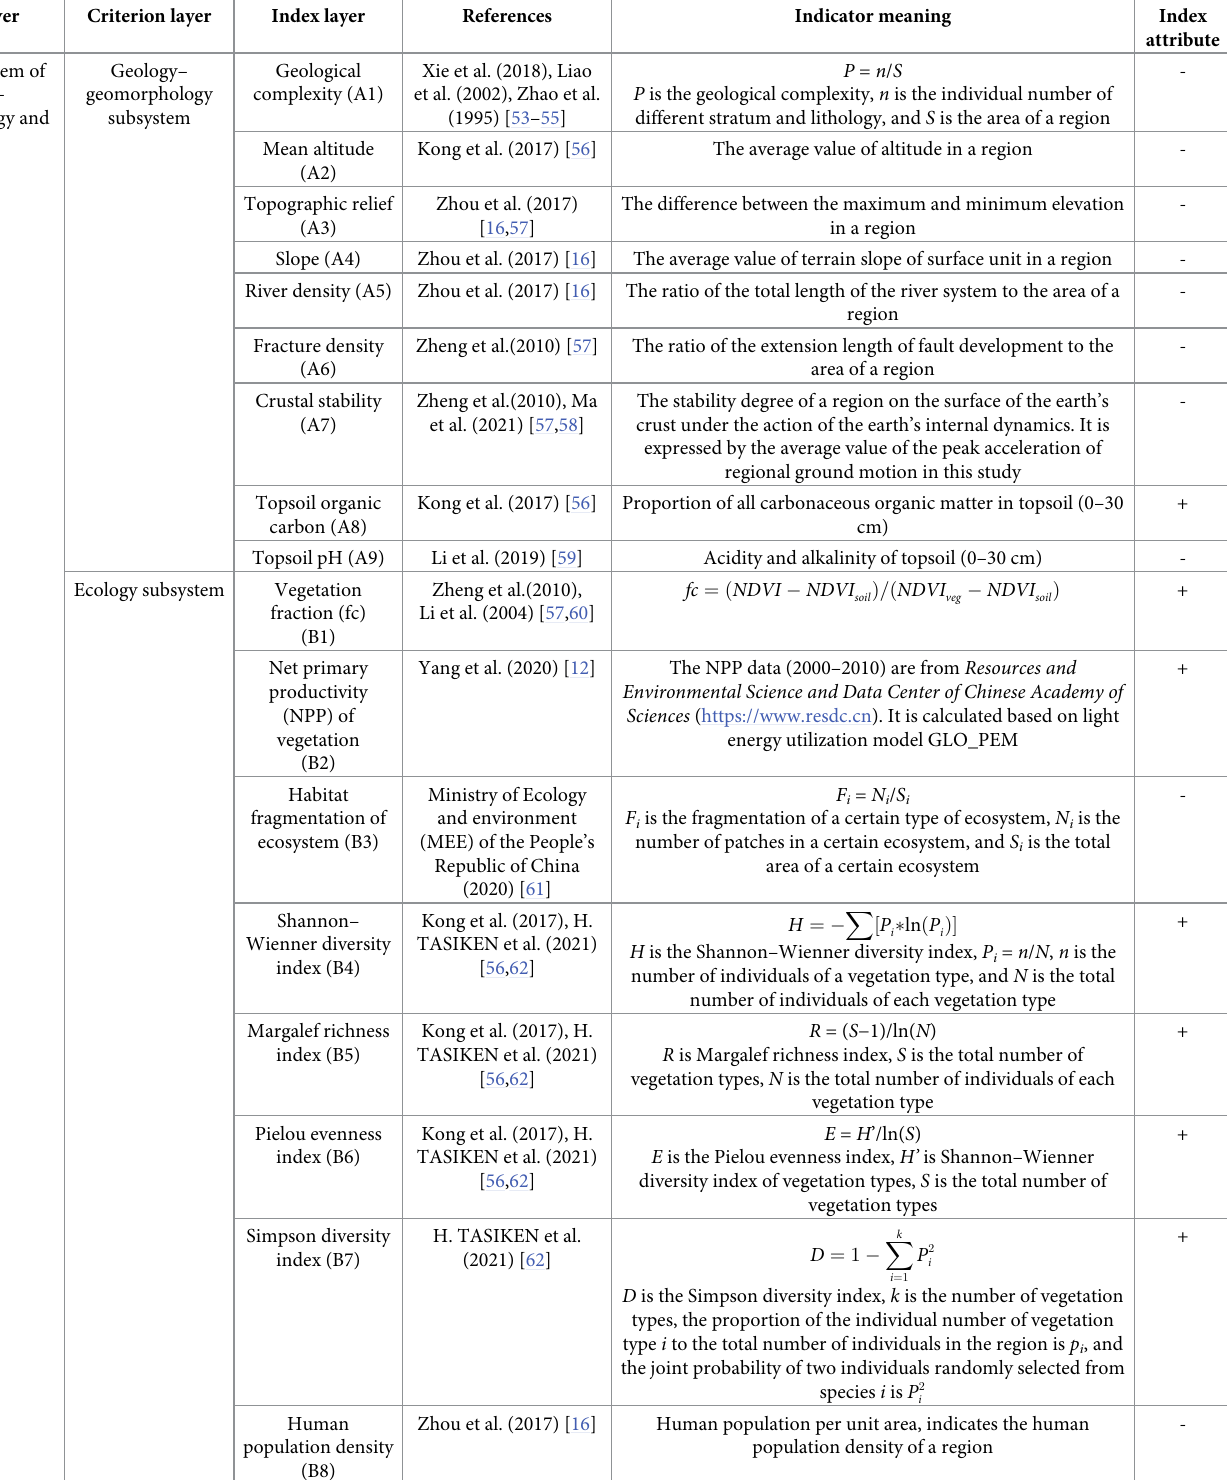
Table 1. Evaluation index system of CCD between geology–geomorphology and